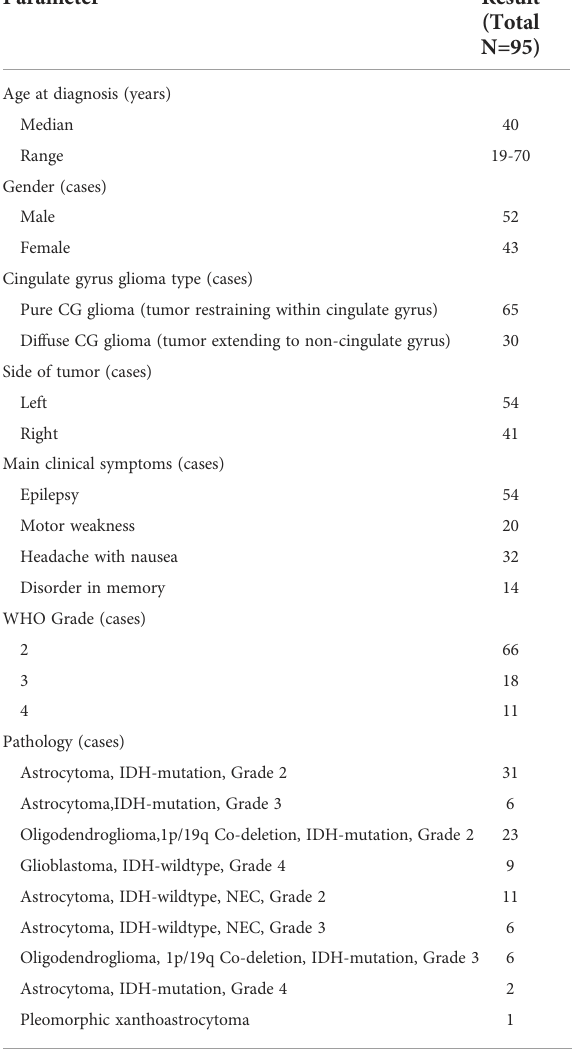
TABLE 1 Summary of Clinical characteristics in 95